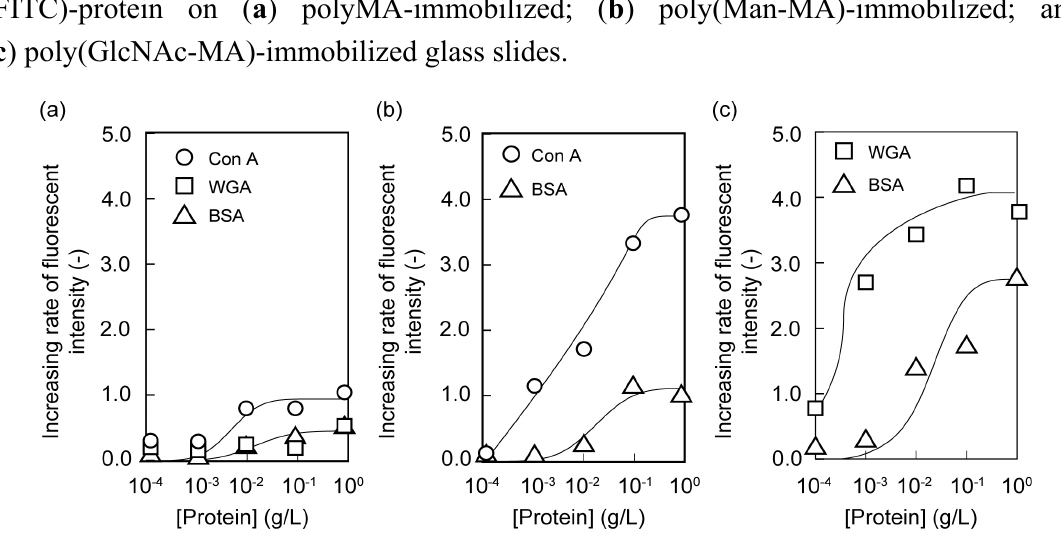
Figure 4. Relative fluorescence intensities of ( a ) Man-pretreated Con A on a poly(Man- MA)-immobilized glass slide and ( b ) GlcNAc-pretreated wheat germ agglutinin (WGA)